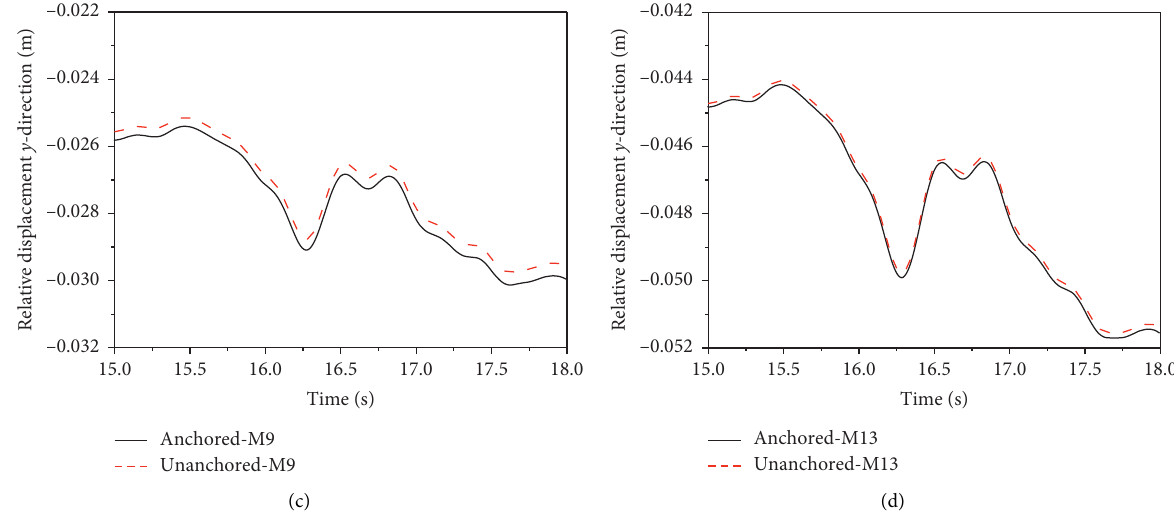
Figure 10: Relative displacement in the y -direction of anchorage grottoes: (a) relative horizontal displacement-time history of some monitoring points with and without anchoring; (b) local magnification of relative horizontal displacement-time history at monitoring point M4 with and without anchoring; (c) local magnification of relative horizontal displacement-time history at monitoring point M9 with and without anchoring; (d) local magnification of relative horizontal displacement-time history at monitoring point M13 with and without anchoring.